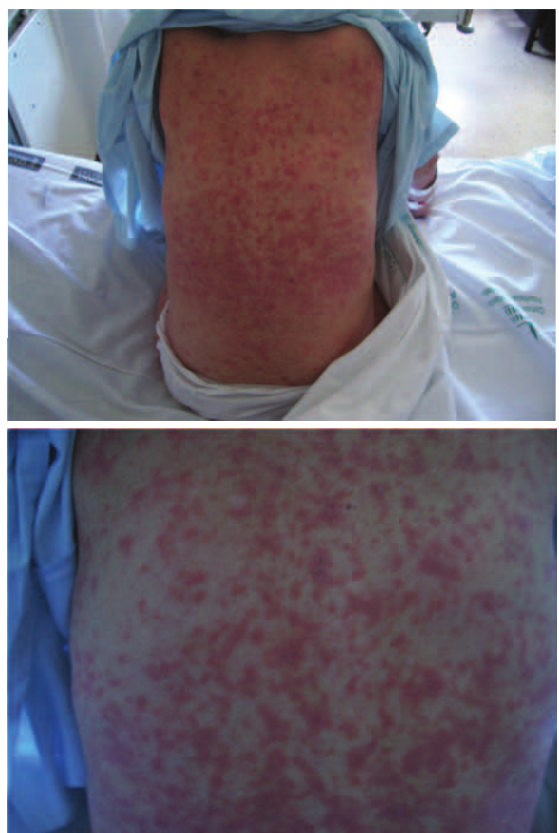
F igure 2, a and b. Papules coalescing into plaques over the trunk.